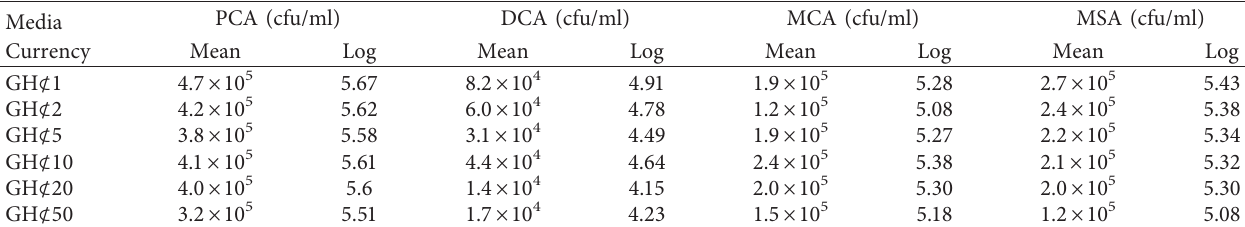
Table 1: Mean microbial counts on different culture media